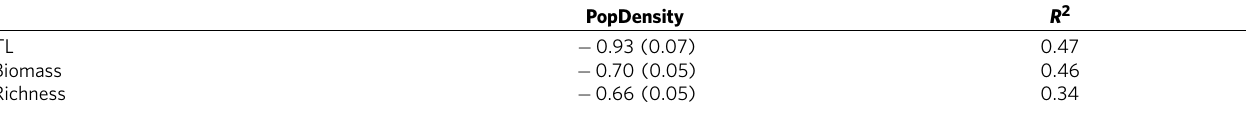
Table 1 | Effects of fishing on the structure of fish communities.